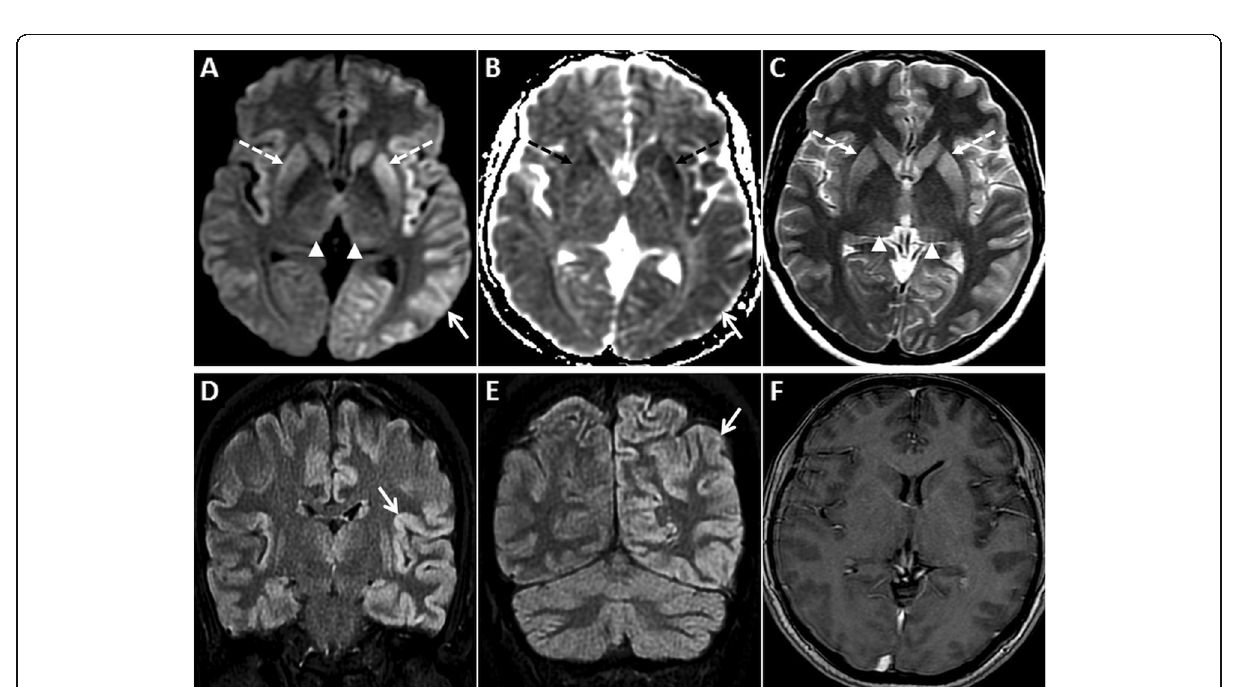
Fig. 10 Pre- and post-contrast MRI of the brain in a 55-year-old male patient who presented with rapidly progressive dementia due to sCJD. GRD is seen in the left temporo-parieto-occipital region (arrows) and in the insular regions on axial DWI ( a ) and ADC image ( b ). Nearly symmetric restricted diffusion is also seen in the basal ganglia (dashed arrows) along with mild DWI hyperintensity in the pulvinar nuclei (arrowheads). Axial T2W image ( c ) shows T2 hyperintensity in the basal ganglia (dashed arrows) and pulvinar nuclei (arrowheads). Sequential anteroposterior FLAIR images ( d , e ) demonstrate the extent of the cortical signal abnormality (arrows). No enhancement is seen in these regions on axial post-contrast T1W image ( f